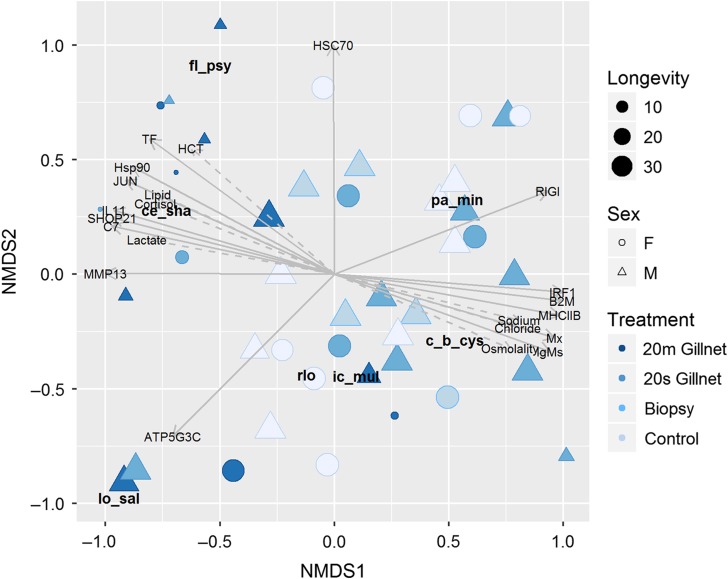
NNMDS plot of microbe productivities within the pooled tissues (gill, liver, spleen, heart, kidney, muscle, brain) of 42 Early Stuart sockeye. Vectors represent correlated (P < 0.10) host gene expression and plasma/muscle biomarkers of stress, condition and immunity. Shapes designate sex (filled circles = females, filled triangles = males) and colour represents the severity of handling and experimental gillnet treatment, with lightest to darkest as non-biopsied controls, biopsied controls, 20-s gillnet-treated, and 20-min gillnet-treated fish, respectively. The size of points represents longevity, with the largest points living the longest.